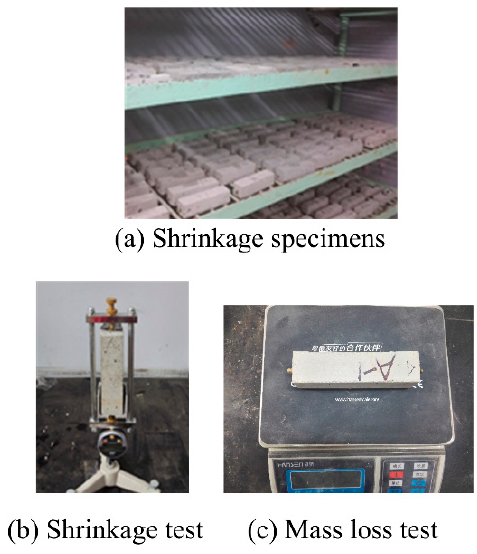
Figure 4. Shrinkage test of mortars.